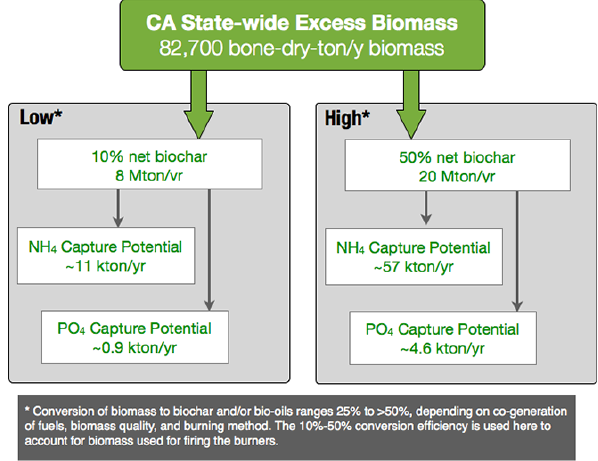
Figure 5. Potential of using biochar for recovering N and P from flushed dairy manure.